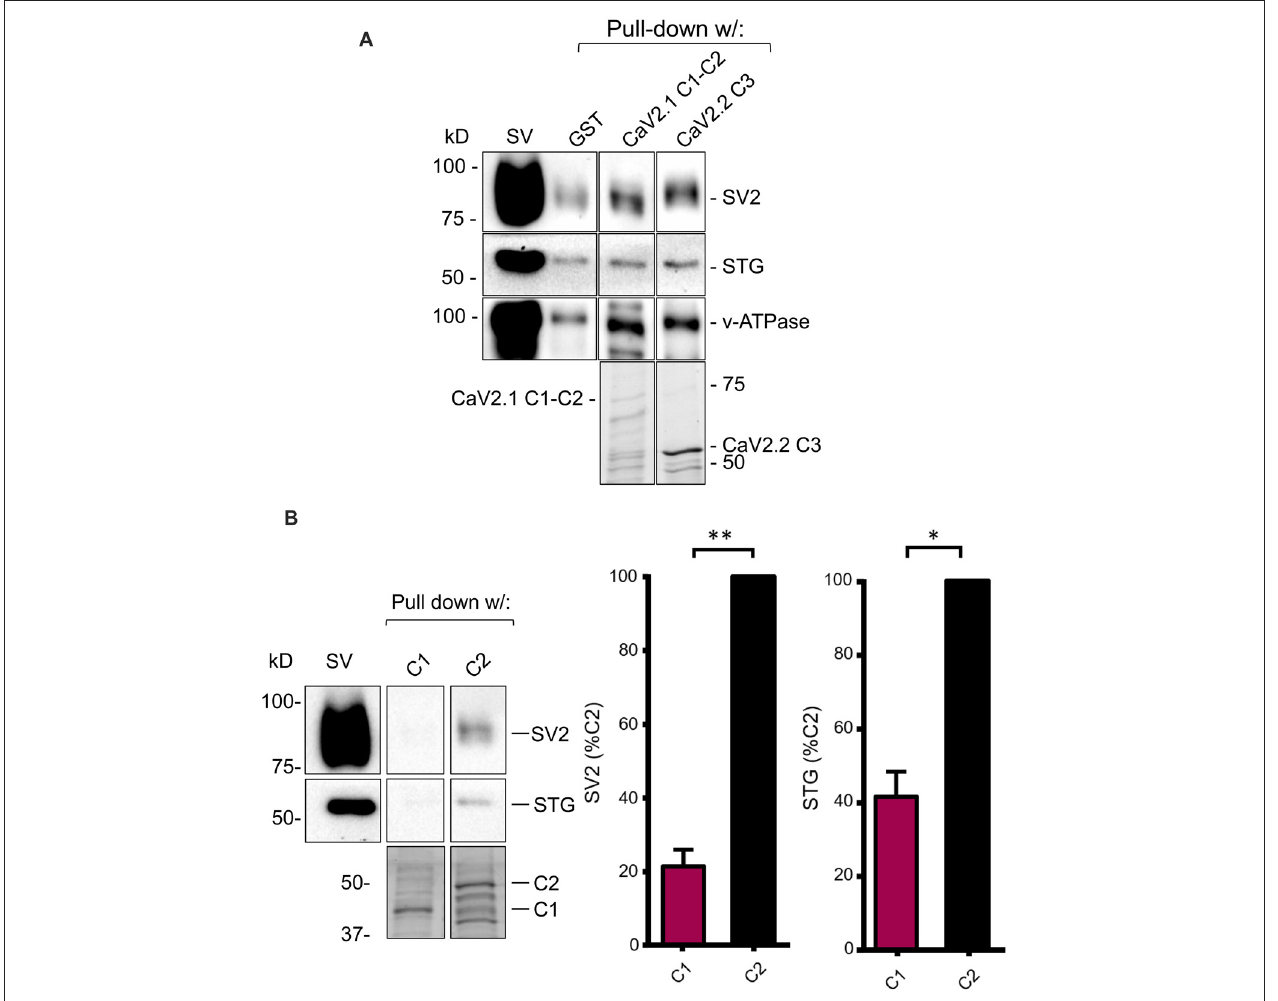
FIGURE 3 | The C2 region of CaV2.1 binds SVs. (A) SV pull-down (SV-PD) using the full-length chick CaV2.1 C-terminal (C1+C2) assessed by SV2, STG and v-ATPase immunoblot. A positive control of SV-PD using the CaV2.2 channel C3 segment is shown for comparison. SV lane: western blot of the SV sample input. In this and all subsequent representative figures all the lanes were taken from a single blot from the same experiment at one given exposure time (see “Materials and Methods” section). (B) Left panel : as in (A) but showing SV-PD with C1 or C2 region fusion proteins. Right panel : histograms comparing SV and STG protein band intensities for the two fusion proteins. ∗ p < 0.05, ∗∗ p < 0.01. Fusion proteins were detected by Coomassie stain unless